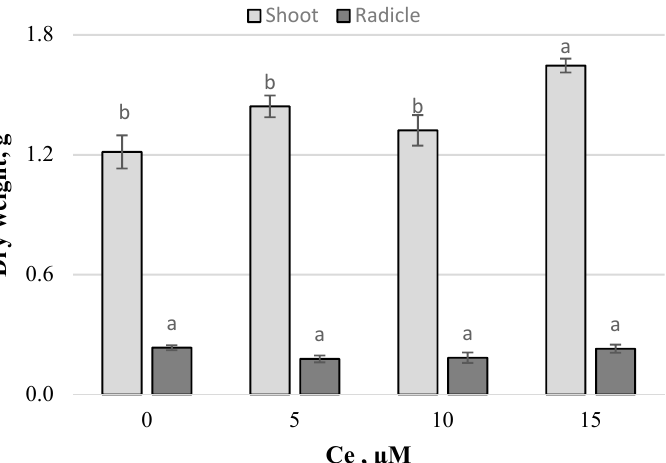
Figure 3. Shoot and radicle dry weight of tomato ( Solanum lycopersicum L.) cv. Vengador seedlings after seven days in germination chambers in solutions with different Ce concentrations. Means ± SDs with different letters in each parameter indicate significant statistical differences (LSD, 0.05).